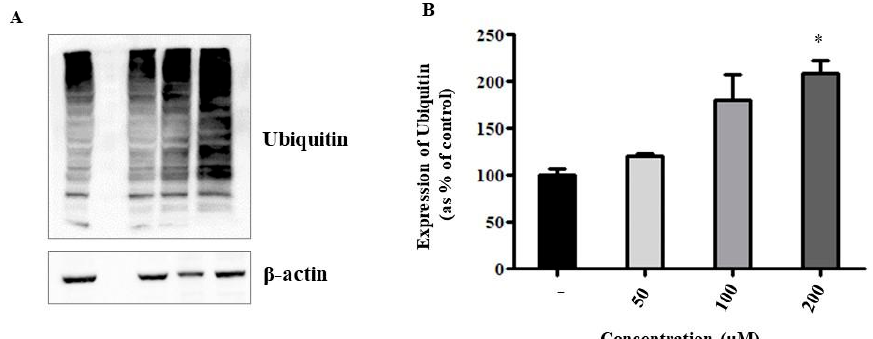
Figure 9. Protein ubiquitination assessment in HepG2 cells exposed to liposomal ANP0903. ( A ) Representative Western blot and ( B ) densitometric analysis of immunoreactive bands. Protein levels were presented as the fold change relative to control cells (CTRL). β -actin was used as the loading control. Data are expressed as means ± Standard Error (SE) of three independent experiments and statistical significance was evaluated with Kruskal-Wallis test (* p < 0.05 vs. CTRL).